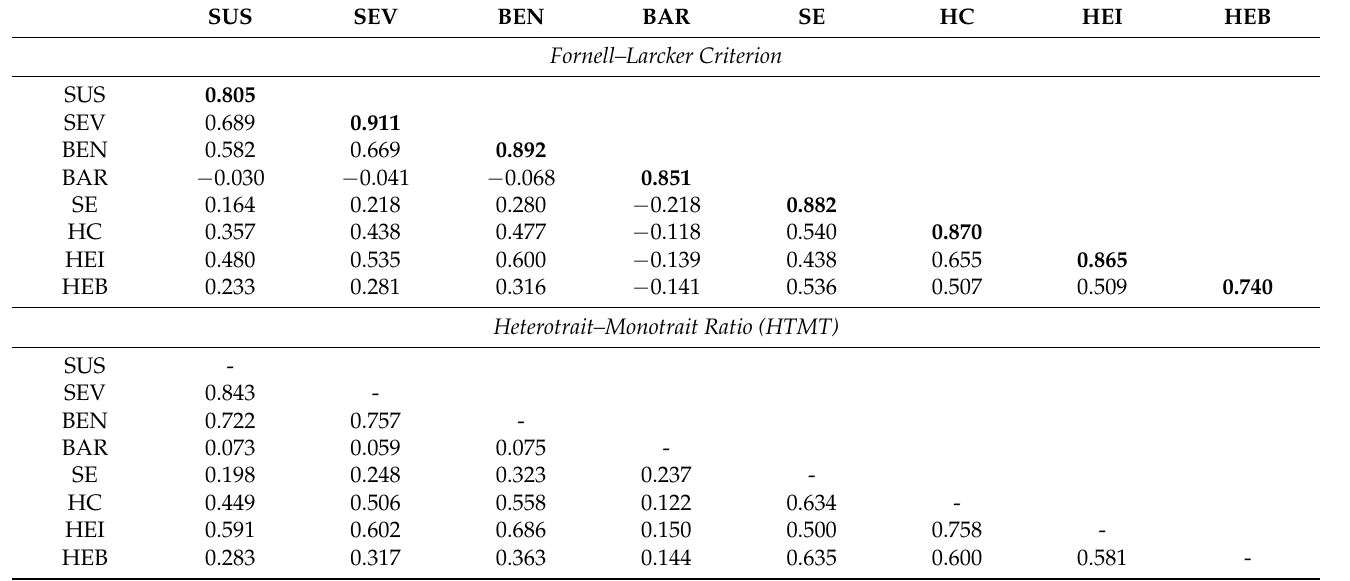
Table 3. The correlation coefficients of latent variables and discriminant